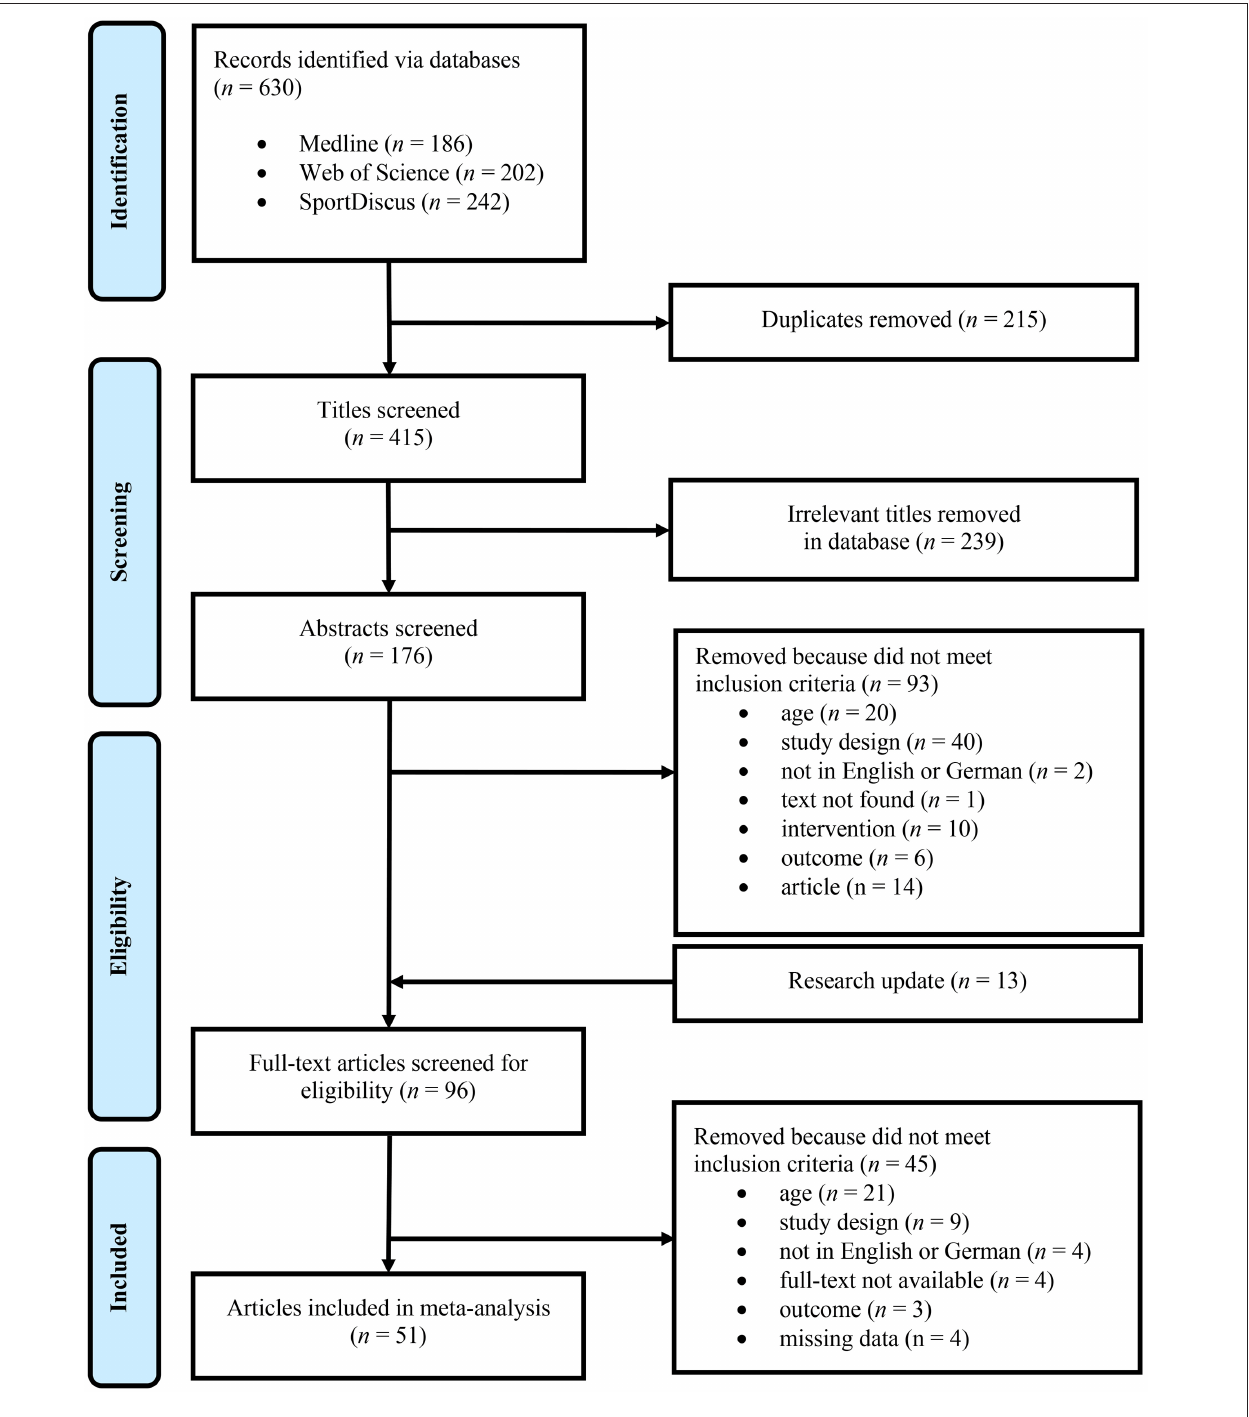
FIGURE 1 | Flowchart demonstrating study screening and selection. studies included three sessions per week. In one case, only one training session was performed per week, but additional home sessions were held daily (69). The training sessions’ duration varied between 30 and 66 min, with more than half of the studies using 60 min as the duration of one training session (n =